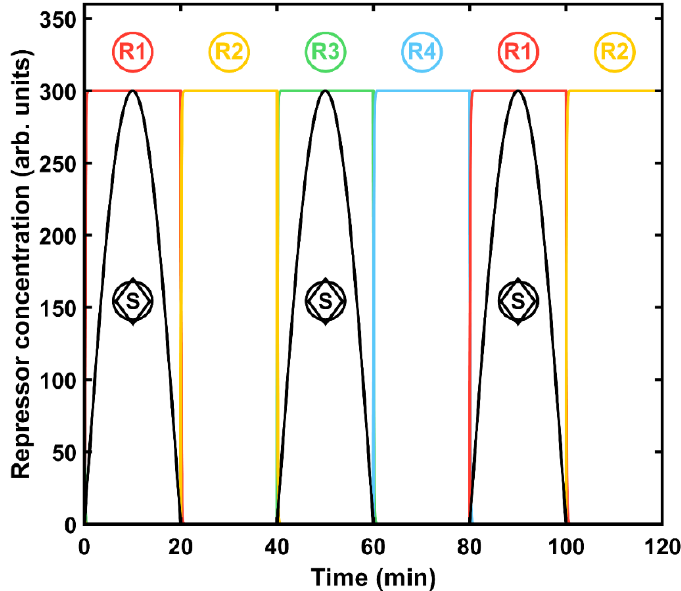
Figure 2. Time evolution of the concentration of each repressor protein R n (corresponding colors displayed) for a coherent design of a four state machine. The sinusoidal input signal (the first half period is a sine function, the second is zero) of an overall period of 40 min is depicted in black.